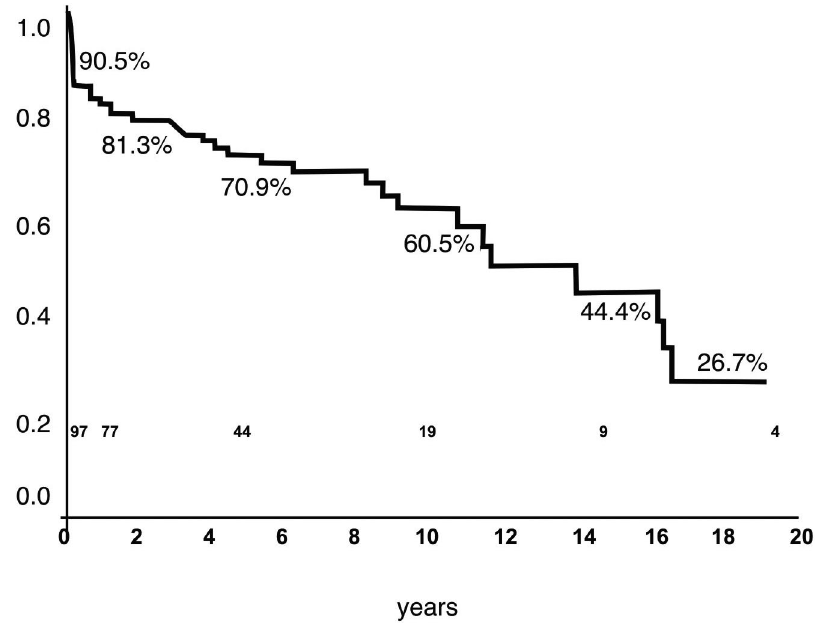
Fig. 2 - Actuarial Survival graph including all patients submitted to heart